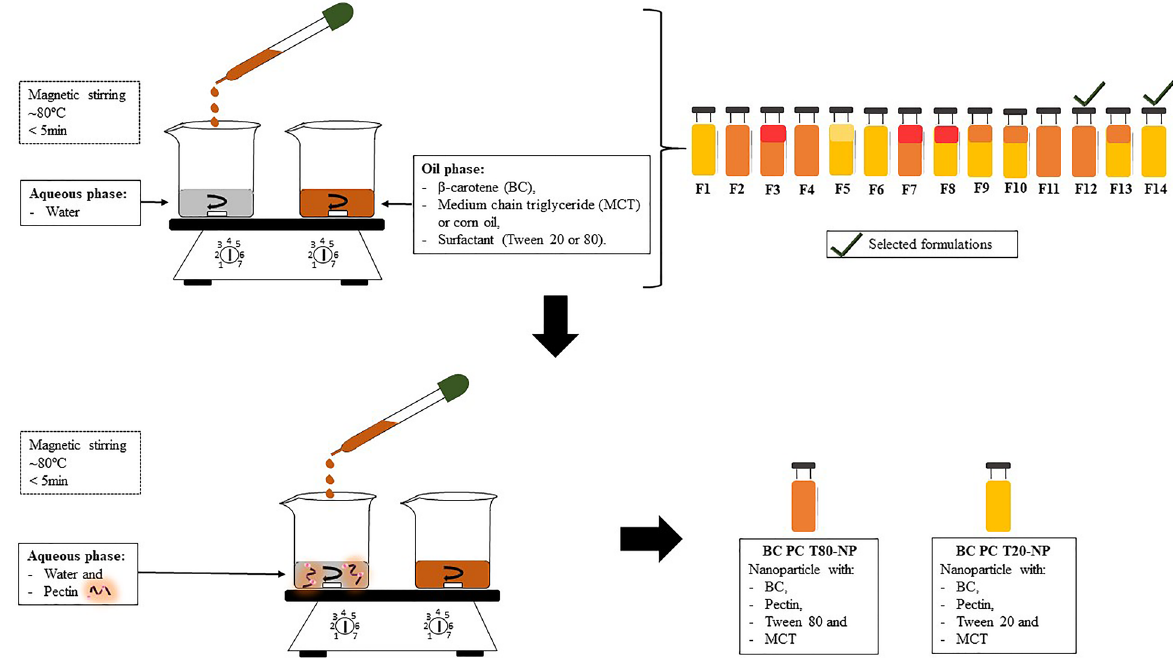
Figure 1. Schematic representation of the stages of development of